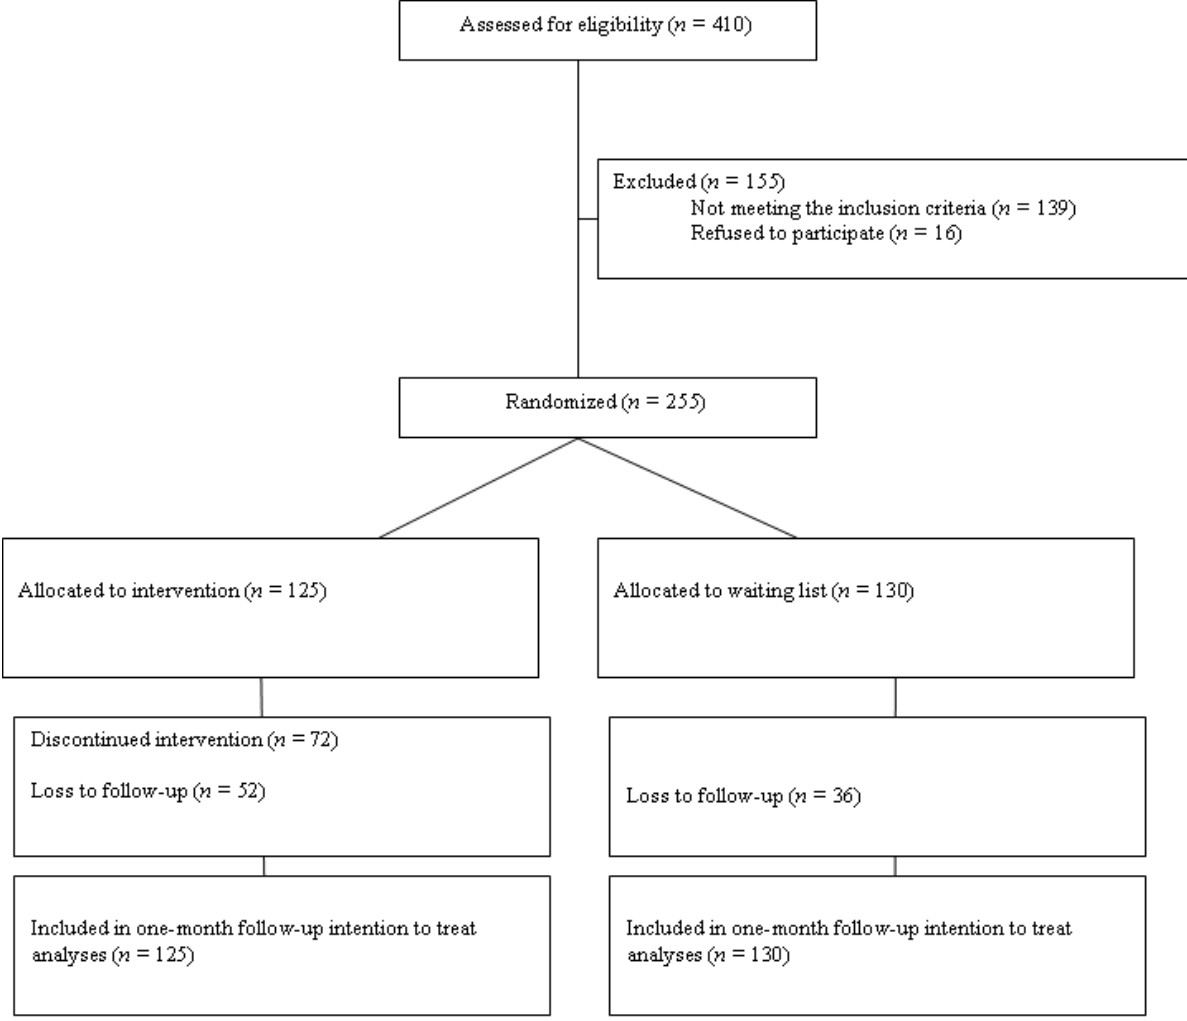
Figure 1. CONSORT study